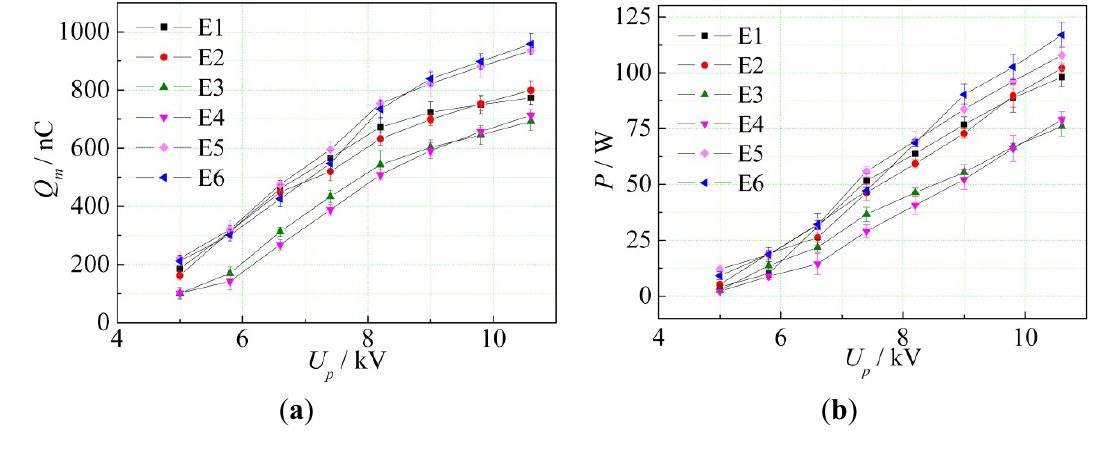
Figure 4. Transported charges per cycle Q using Lissajous figures as a function of operating voltage: ( a ) Transported charges per cycle Q ; ( b ) Discharge power P m